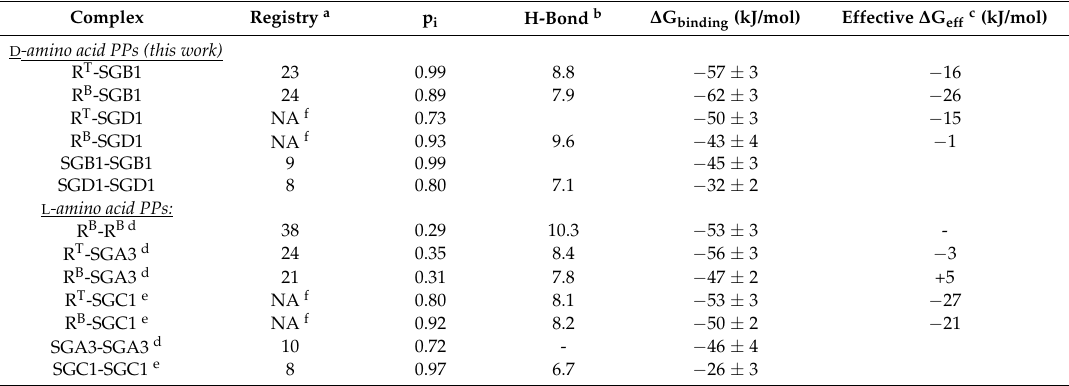
Table 1. The registry, population (p i ) and average number of intermolecular hydrogen bonds (H-bond) for the first clusters of R-complexes of pseudo-peptides (the top and bottom edge) and the homodimers, with their corresponding ∆ G dis , from umbrella